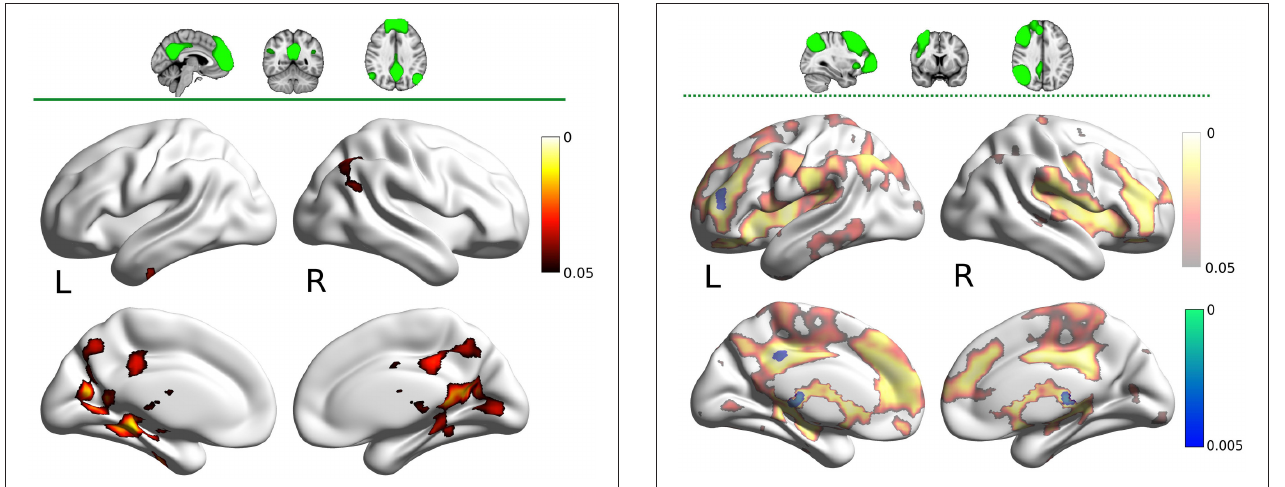
FIGURE 5 | Results for the right fronto-parietal network (RFPN) mask (two dimensional image on top, with mask shaded in green, centered at x = 32 , y = 7 , z = 35 ). Warm colors present the cluster of decreased connectivity in carnosine/anserine subjects (multiple comparison FWE corrected, p < 0.05). Bluish colors present the areas in which carnosine/anserine subjects have decreased connectivity as compared to placebo with additional Bonferroni correction ( p < 0.005). Left (L) and right (R) hemispheres are presented